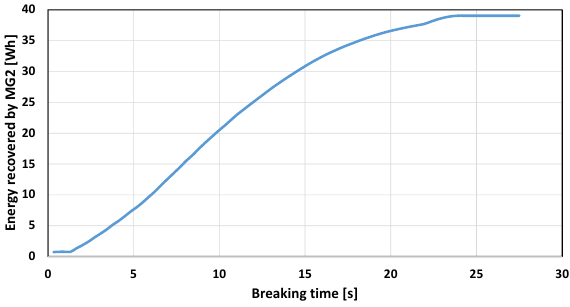
Fig. 5. The course of energy recovery in the braking process in a hybrid drive system